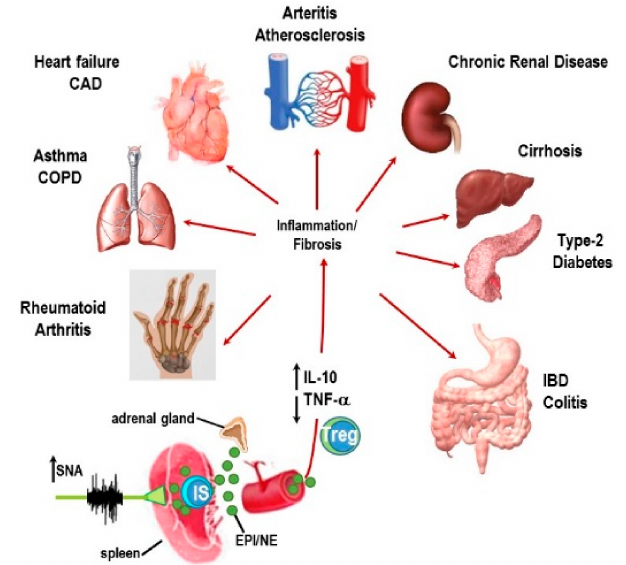
Figure 5. One mechanism is proposed whereby high sympathetic nerve activity (SNA) in the spleen may dampen systemic inflammation (red arrows) in immune-mediated inflammatory diseases (IMIDs). In the spleen, a β 2 -AR-mediated increase of interleukin-10 (IL-10, upward arrow) secretion and inhibition of tumor necrosis factor (TNF- α , downward arrow) by splenic immunocytes into the systemic circulation exert anti-inflammatory actions in tissues and organs (indicated by red arrows) that are targeted by IMIDs, including inflammatory bowel diseases (IBD) such as colitis, type-2 diabetes, cirrhosis, chronic renal disease, arteritis, atherosclerosis, chronic heart failure, coronary artery disease (CAD), asthma, chronic obstructive pulmonary disease (COPD), and rheumatoid